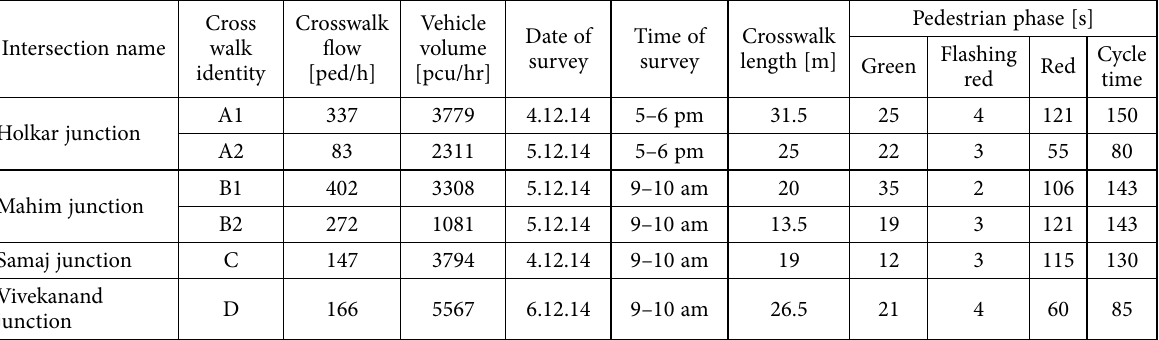
Fig. Selected study location in Mumbai (India) Table 1. Study location and field observed